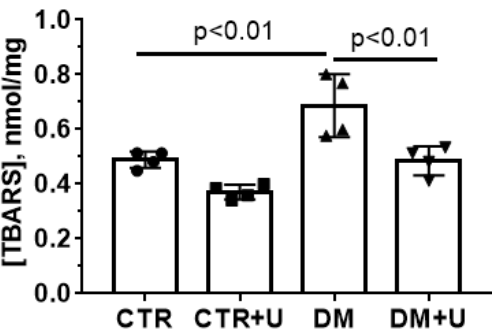
Figure 5. Uridine treatment suppresses the DM-induced lipid peroxidation in the heart mitochon- dria of experimental animals. Lipid peroxidation was assessed by the level of thiobarbituric acid- reactive substances (TBRAS) in the heart mitochondria of the experimental animals. All data are means ± SD ( n = 4).